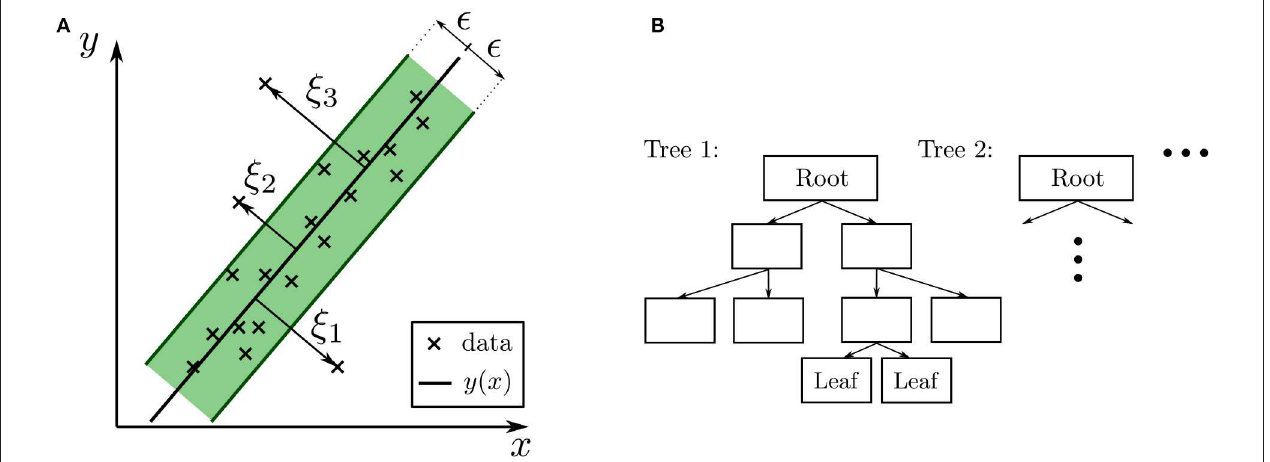
FIGURE 3 | Illustration of the Machine Learning (ML) regression models. (A) SVR: example of a two-dimensional problem as described in section 3.1 with the margin of two times ǫ and slack variables ξ i (B) RFR: example of Decision Tree (Tree 1) with depth three (cf. section